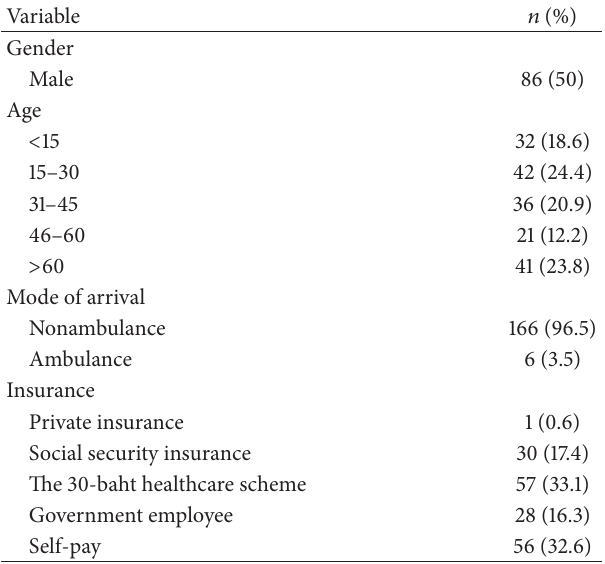
Table 1: Demographics of revisiting patients, 𝑛 = 172 .